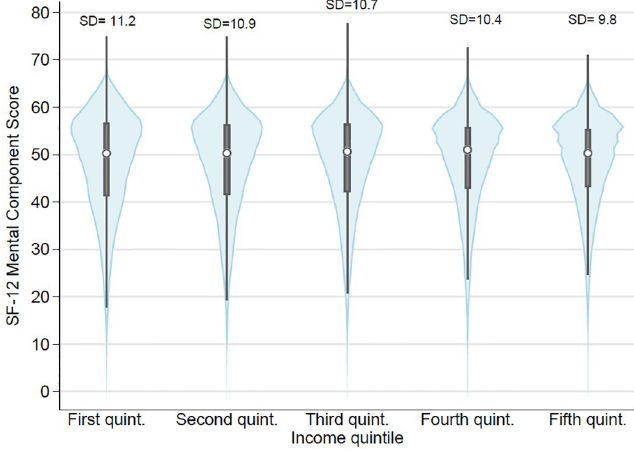
Fig 4. Violin plots of SF-12 MCS scores by net equivalised household income